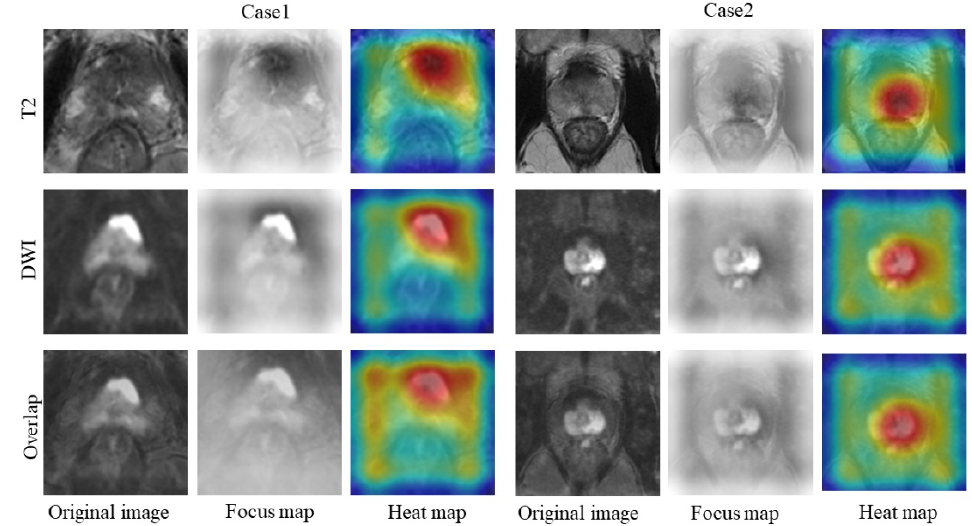
Figure 4. The 3D-CNN model was visualized for learning. The figure shows two cases; the first column of each case is the original image, the second column is the focus map obtained through calculation, and the third column is the heat map obtained through the 3D Grad-cam++ calculation.